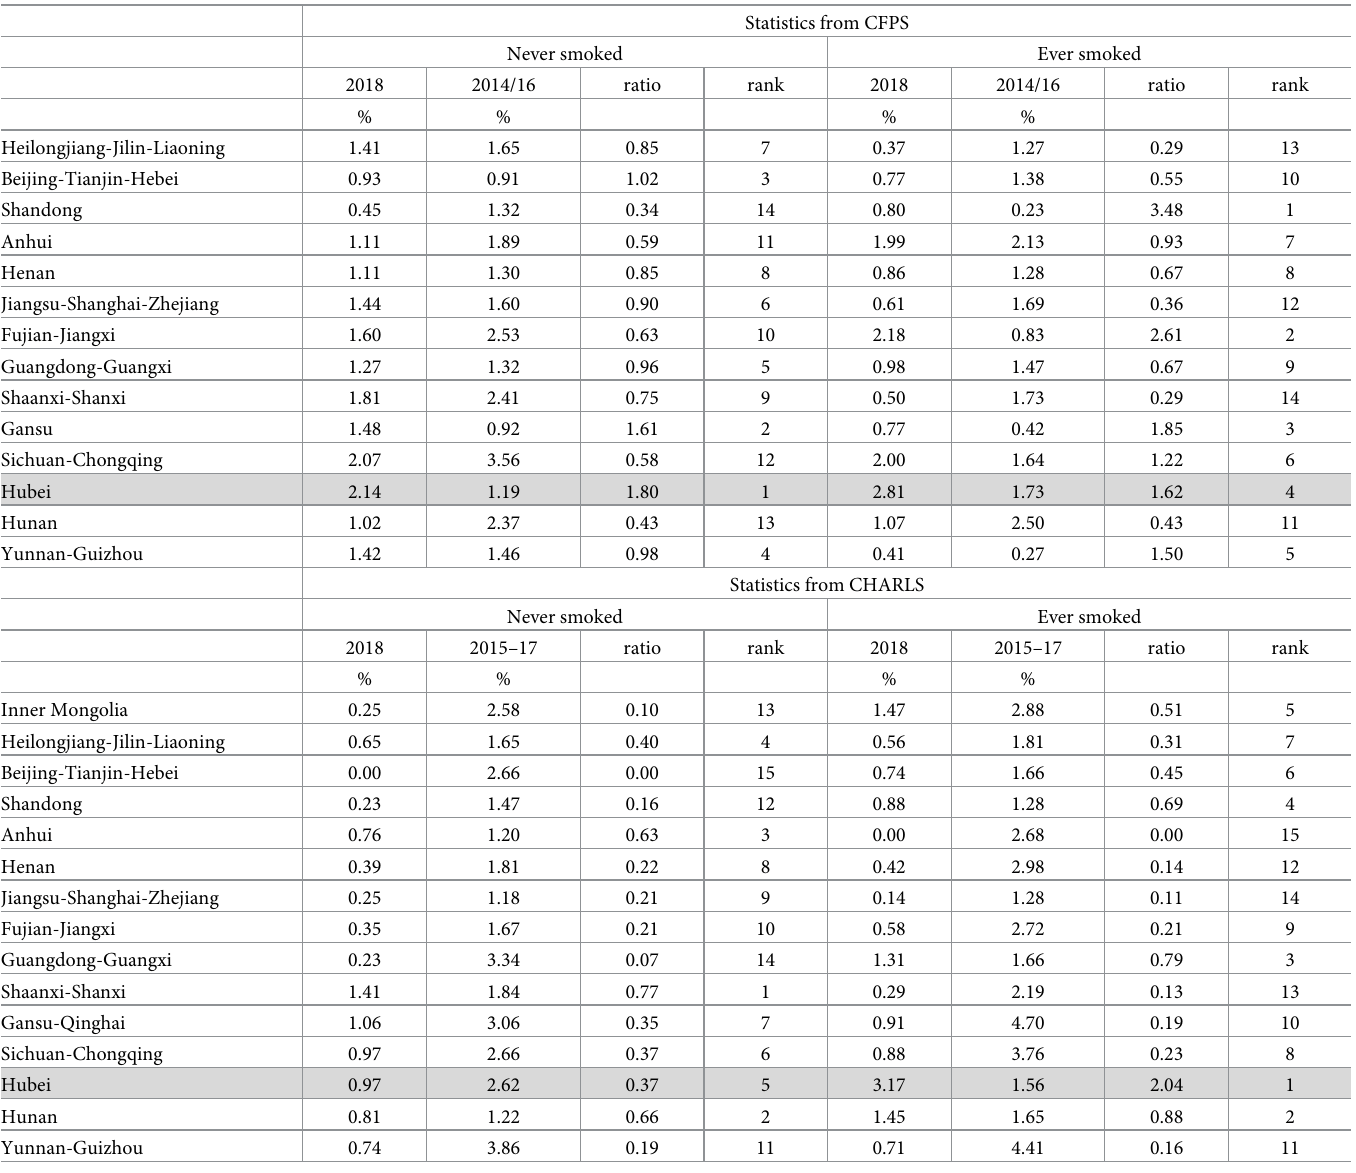
Table 8. Diagnosis of lung disease by smoking